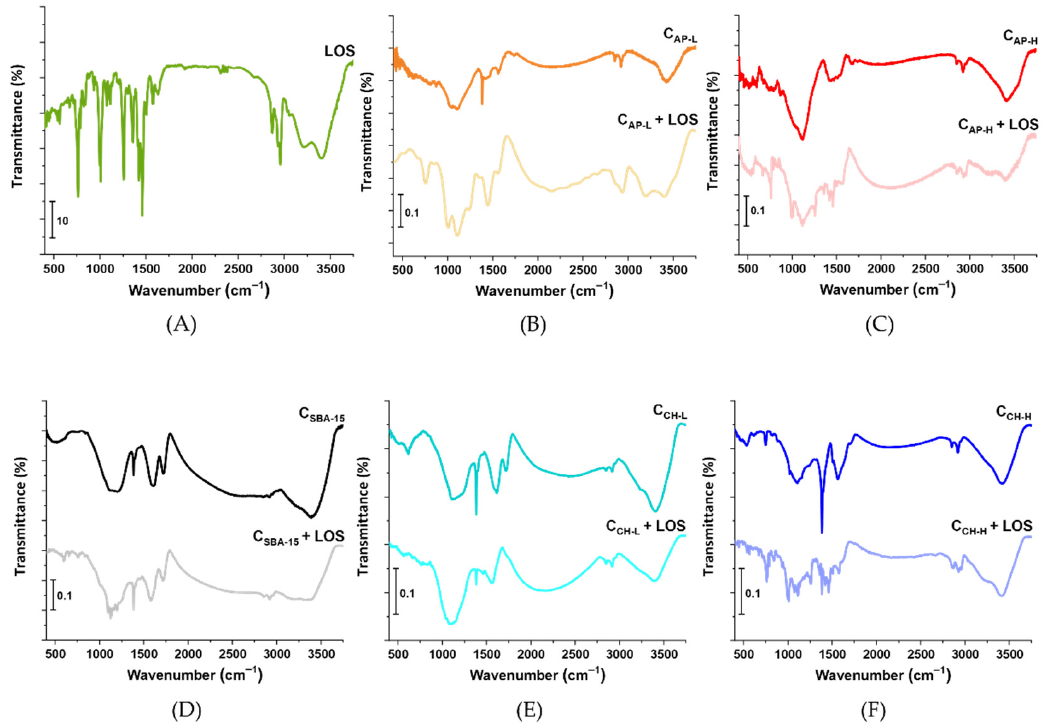
Figure 6. FT-IR spectra of losartan potassium ( A ), pure carbon materials and carrier-API systems: C AP-L ( B ), C AP-H ( C ), C SBA-15 ( D ), C CH-L ( E ), and C CH-H ( F ).